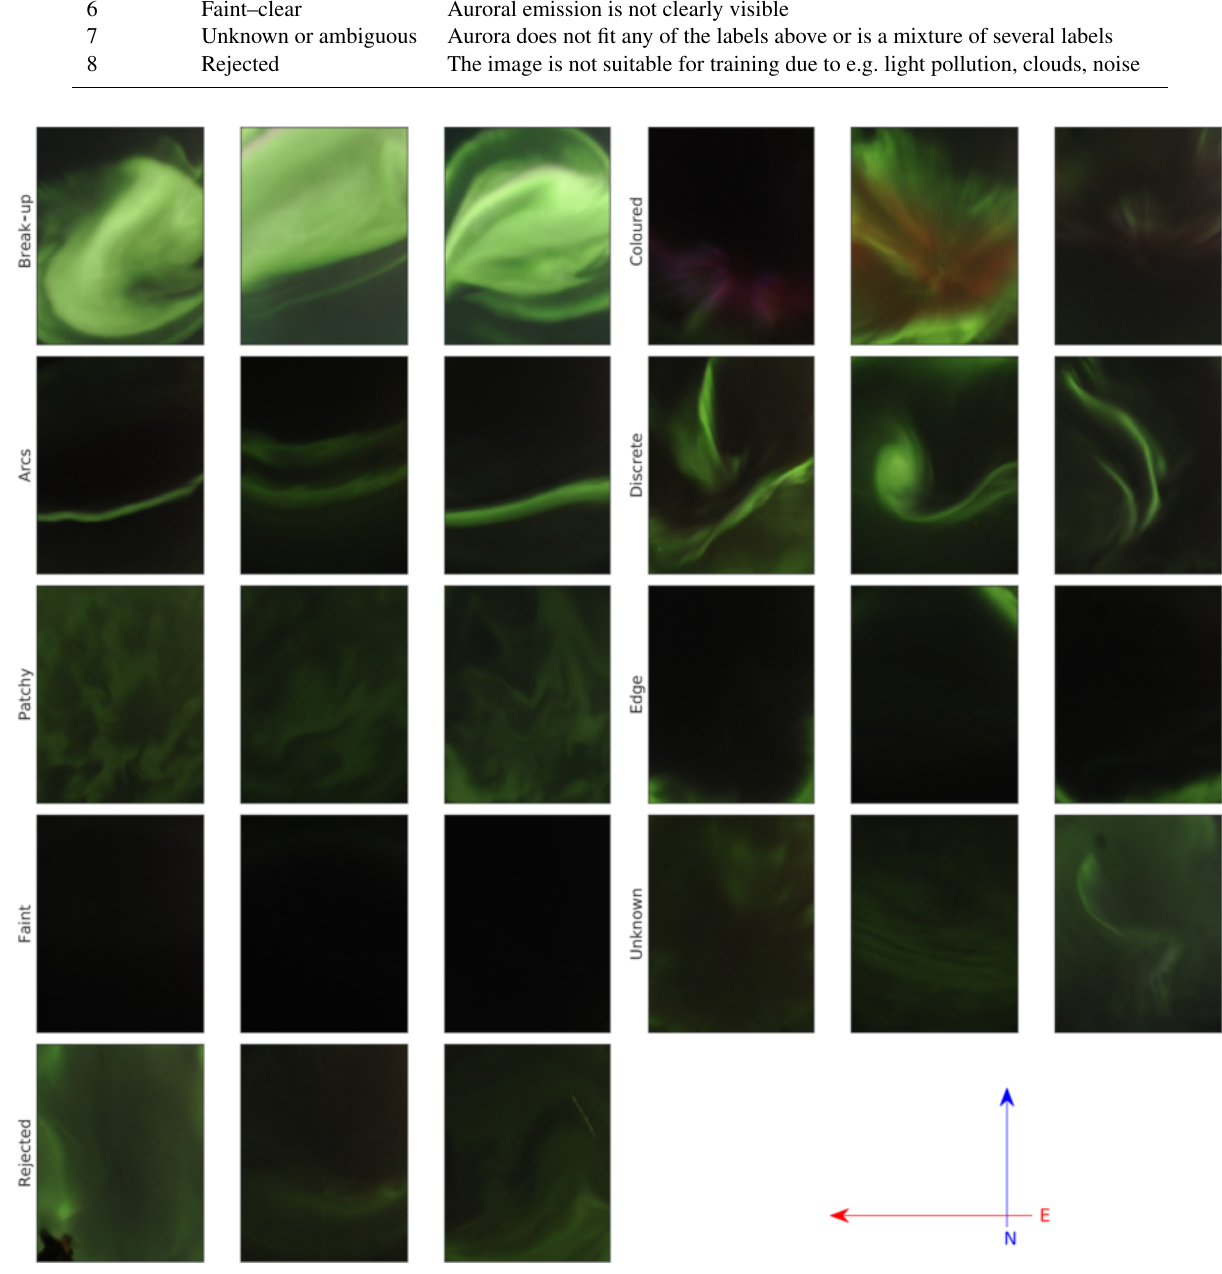
Figure 1. Sample images of each label. The direction with respect to the magnetic pole is indicated by the arrows at the bottom right. The rejected images at the bottom left are rejected due to, from left to right, a person in the bottom left corner, lidar emission and passing